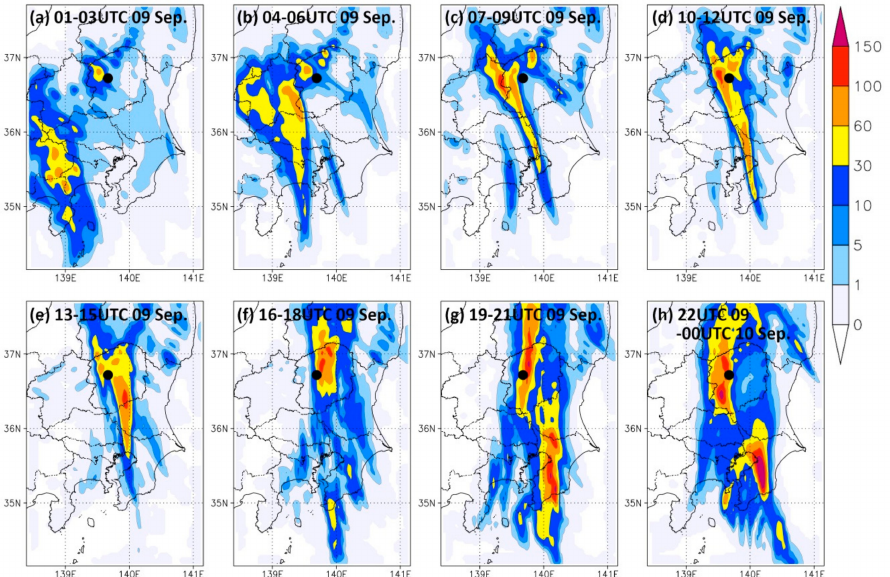
Figure 5. 3-hourly rainfall by the hindcast simulation (a member starts at 00 UTC 7 September). Result of ( a ) 01–03 UTC, ( b ) 04–06 UTC, ( c ) 07–09 UTC, ( d ) 10–12 UTC, ( e ) 13–15 UTC, ( f ) 16–18 UTC, ( g ) 19–21 UTC on 9 September. ( h ) Result of 22 UTC on 9 September–00 UTC on 10 September. The unit of the color bar is mm / 3 h. Filled black circle indicate the location of the Nikko